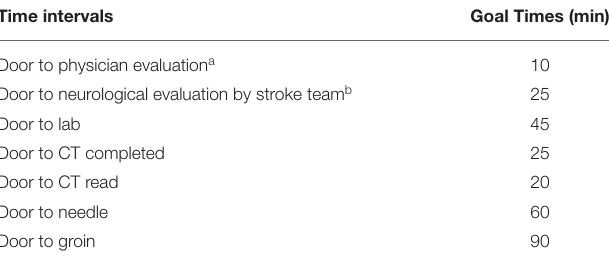
TABLE 1 | Stroke critical time